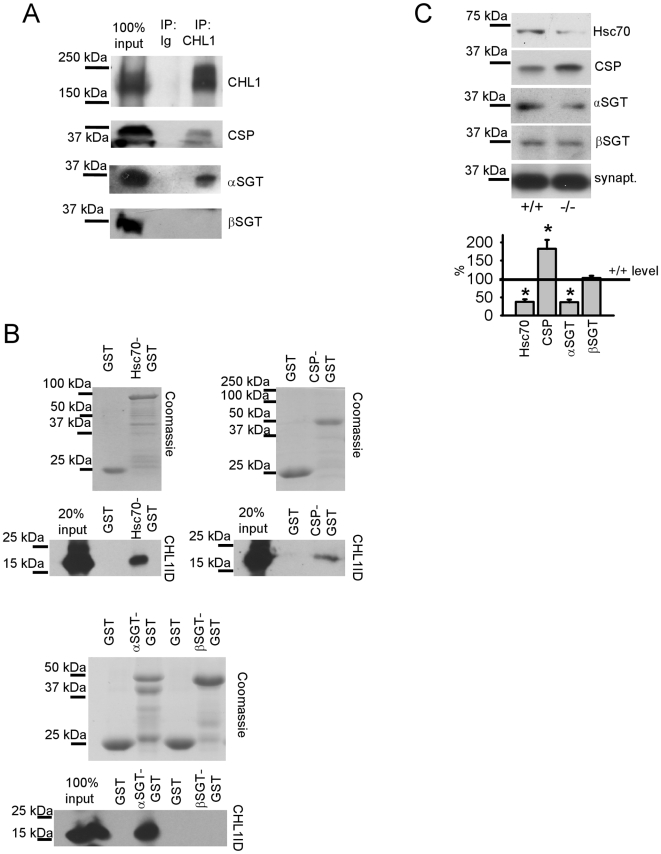
CHL1 interacts with Hsc70, CSP and αSGT.
A - CHL1 immunoprecipitates (IP) from brain lysates and input material were probed with antibodies against CSP, αSGT and βSGT by Western blot. Mock IP with non-specific immunoglobulins (Ig) was performed for control. CSP and αSGT, but not βSGT co-immunoprecipitated with CHL1. B - GST and GST-tagged Hsc70, CSP, αSGT, βSGT immobilized on beads were assayed for their ability to pull down CHL1ID. Coomassie blue stained gels show that levels of Hsc70, CSP, αSGT and βSGT immobilized on beads were similar or lower than levels of GST on control beads. Lower molecular weight products of the recombinant proteins derive from degradation. CHL1ID was pulled down with Hsc70, CSP and αSGT, but not with GST or βSGT. Input shows levels of CHL1ID taken for the pull down assay. C - CHL1+/+ and CHL1−/− synaptic vesicles were probed by Western blot with the indicated antibodies. Graphs show mean optical density of the protein bands in CHL1−/− synaptic vesicles ± SEM (n = 6) normalized to the optical density in CHL1+/+ set to 100%. Levels of Hsc70 and αSGT are decreased while levels of CSP are increased in CHL1−/− synaptic vesicles. Levels of βSGT are similar in both genotypes. Synaptophysin (synapt.) served as a loading control. *p<0.05, paired t-test (when compared to CHL1+/+ level (solid line)).